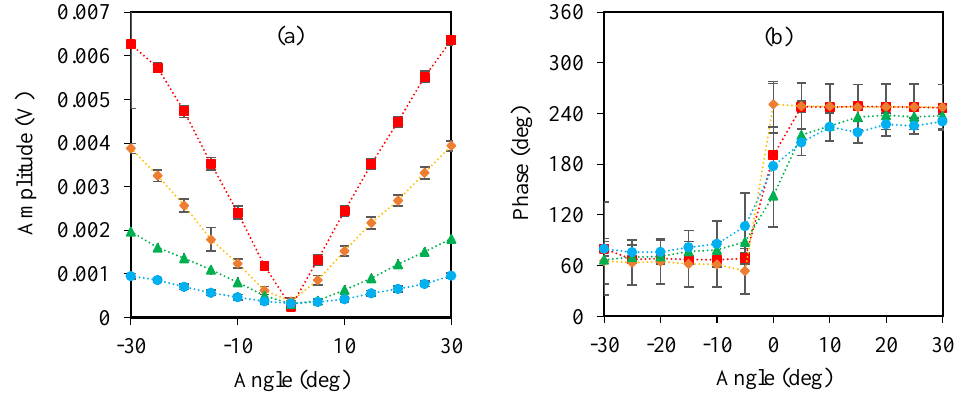
Figure 4. Amplitude ( a ) and phase ( b ) of the rf signal as a function of the angle between the normal to the object surface and the sensor axis recorded over the copper plates with lift-off values of 3mm (red squares), 10mm (orange diamonds), 20mm (green triangles), and 30mm (blue circles). Lines connecting points serve only to guide the eye. The measurement was performed at an operating frequency of 40kHz. The plate was positioned so that it was centred along the axis of the primary rf field coil.